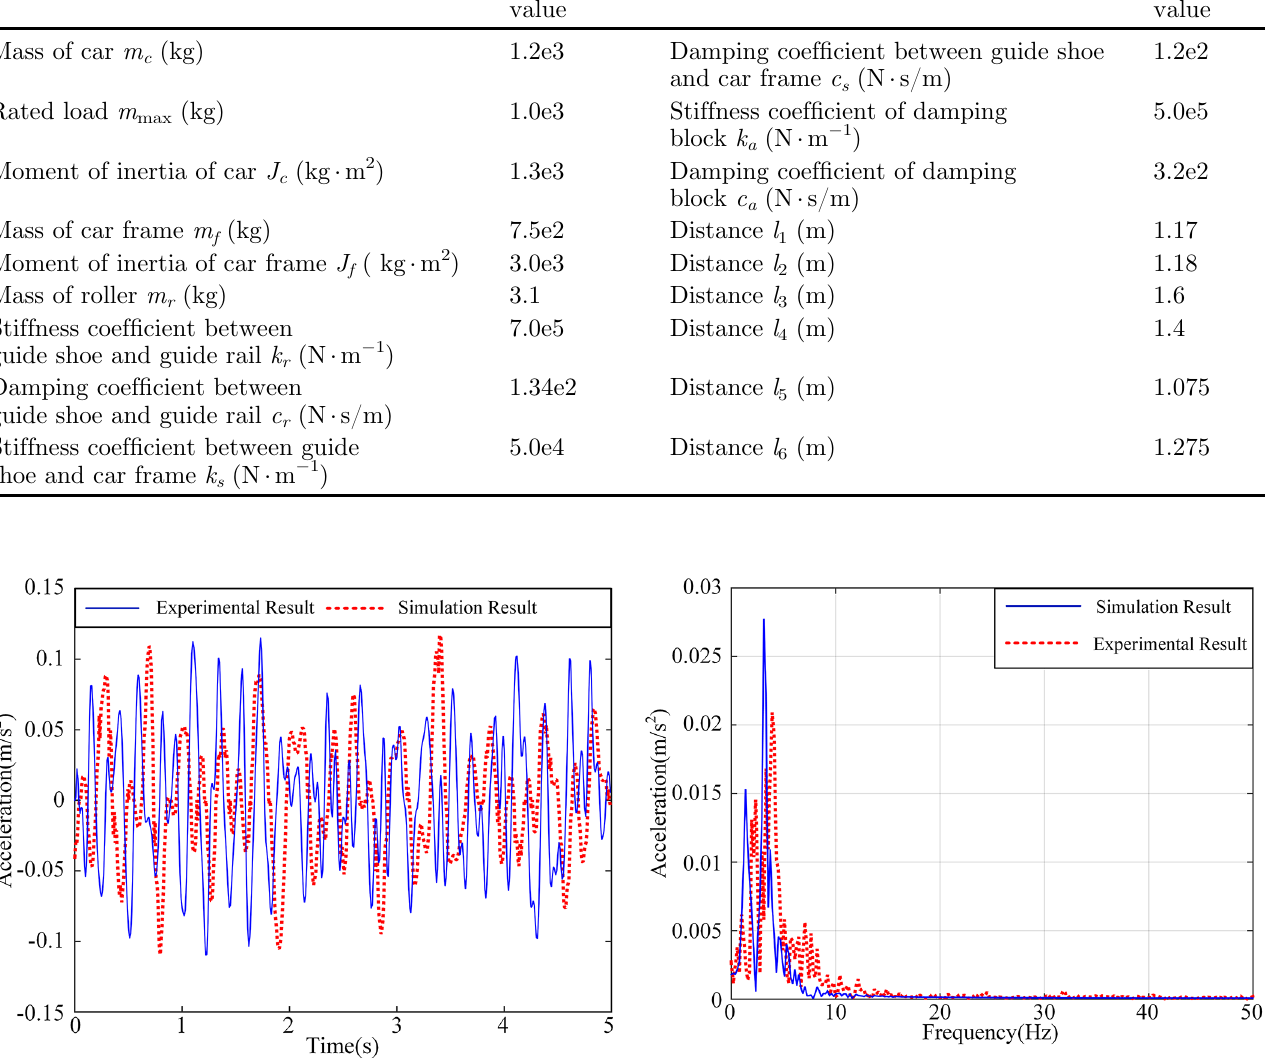
Fig. 11. Time-domain diagram contrasting the actual accelera- tion and the simulated acceleration of the car frame.